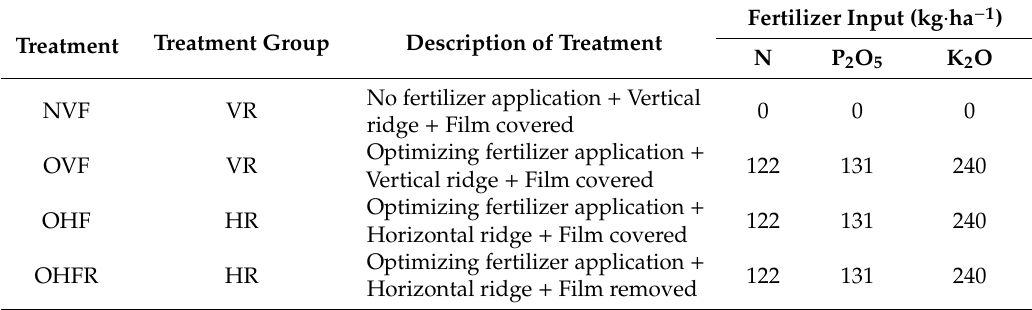
Table 1. Treatments, description, and fertilizer input for the study of e ff ects of cultivation pattern on erosion and nutrient loss from sloping land on red soil in southwestern